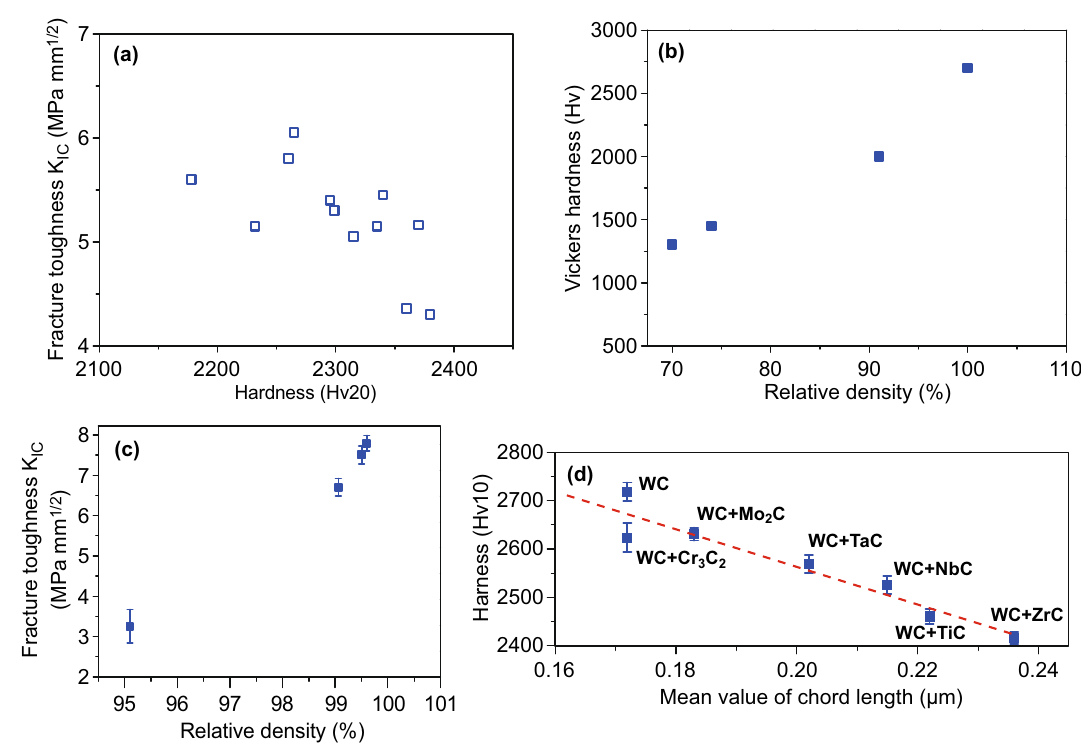
Fig. 17 a Plot of fracture toughness versus hardness of BTC [126]. b Plot of hardness and c fracture toughness versus relative density [119, 179]. d Plot of hardness versus chord length of dense samples [180]. Figure panels reproduced from Ref. [126] with permission from IEEE copyright 2005, Ref. [119] with permission from Elsevier copyright 2006, Ref. [179] with permission from Elsevier copyright 2017, Ref. [180] with permission from EPMA copyright